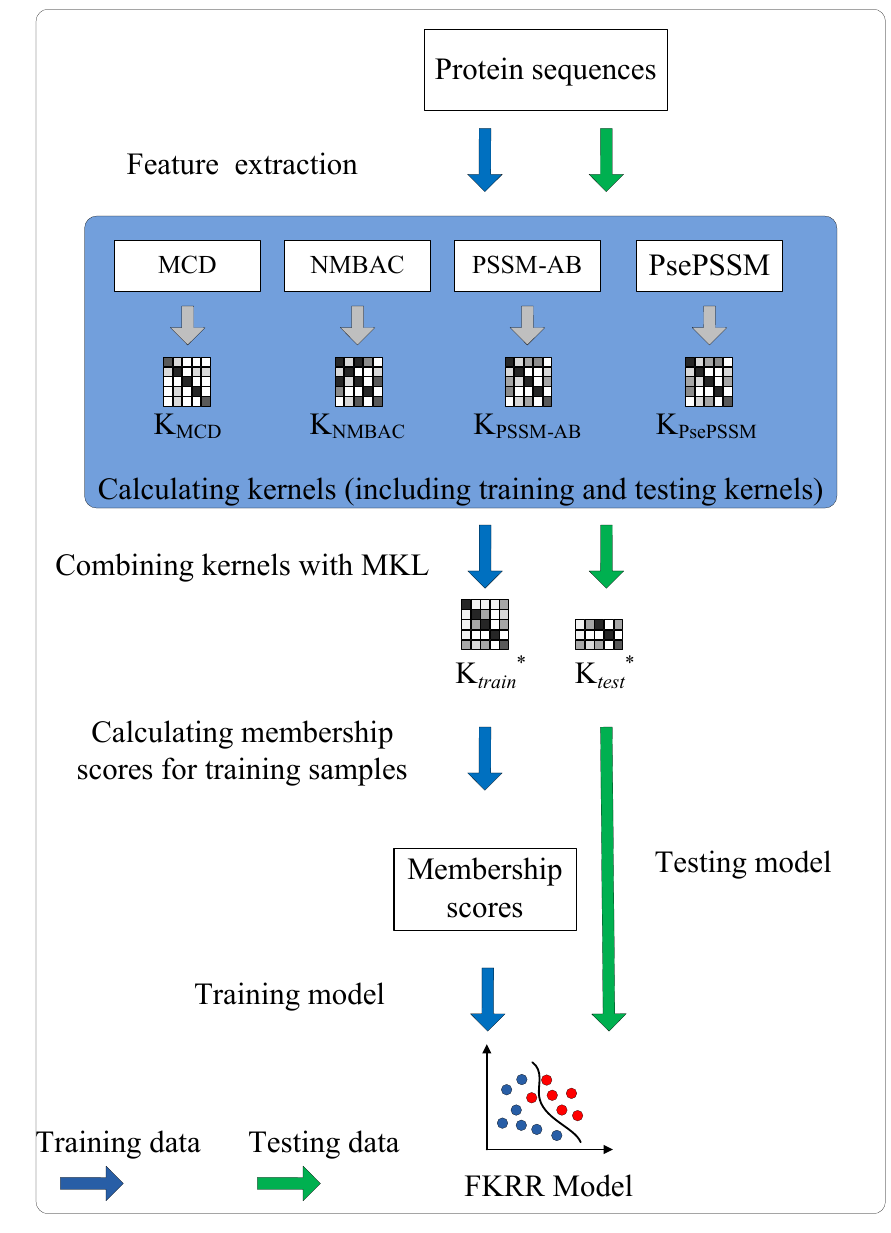
Figure 4. The process of